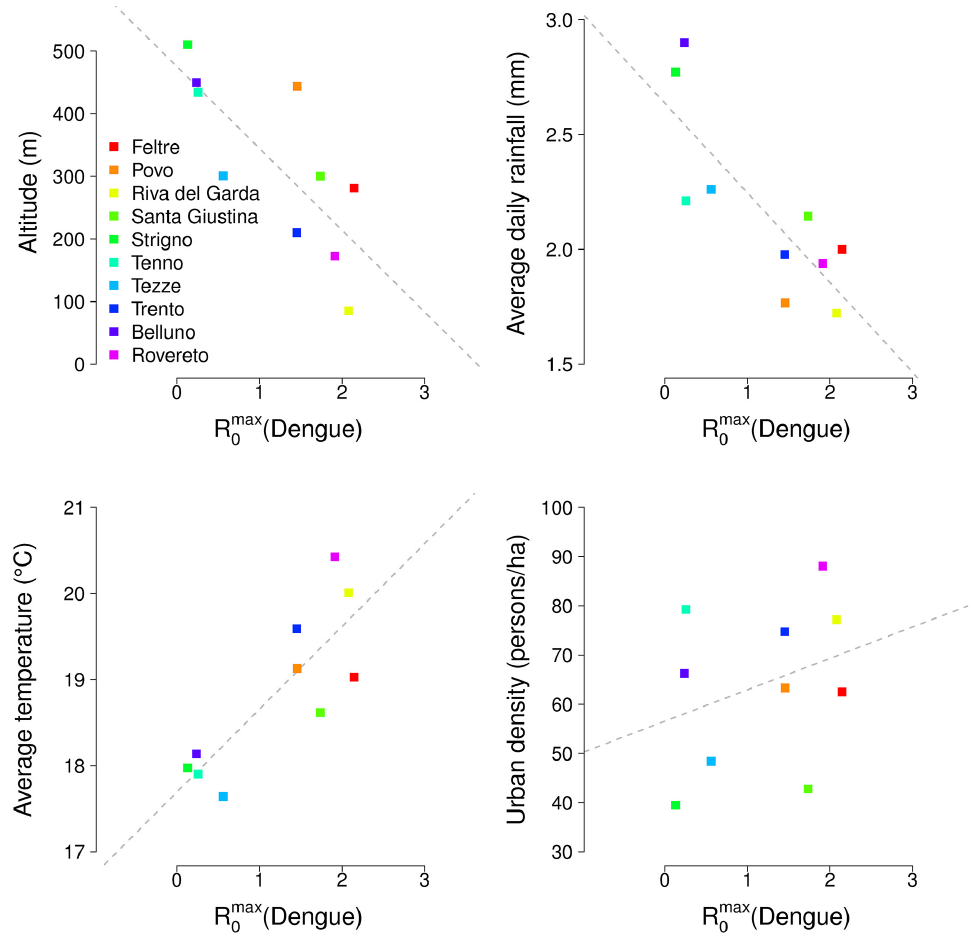
doi:10.1371/journal.pntd.0004762.g005